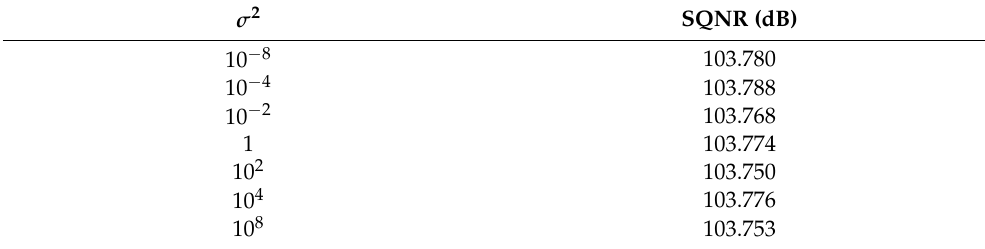
Table 3. Values of SQNR (dB) obtained by simulation of the 24-bit floating-point format FP24 for different values of variance σ 2